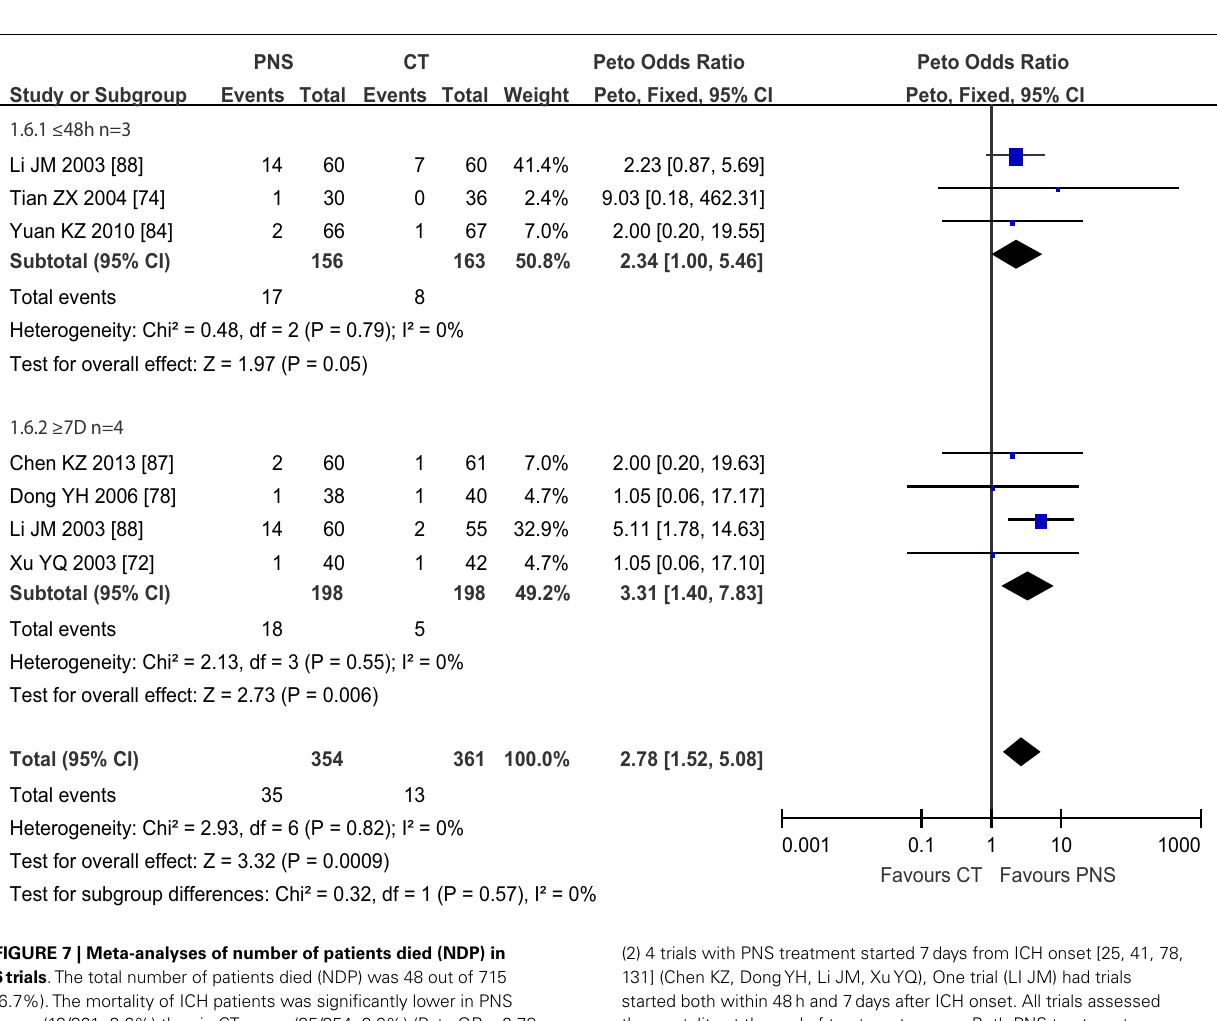
FIGURE 7 | Meta-analyses of number of patients died (NDP) in 6trials .The total number of patients died (NDP) was 48 out of 715 (6.7%).The mortality of ICH patients was significantly lower in PNS group (13/361, 3.6%) than in CT group (35/354, 9.9%) (Peto OR = 2.78; 95% CI = 1.52, 5.08; P = 0.0009).The trials were divided into two subgroups based on the intervention time of PNS: (1) 3 trials with PNS treatment started within 48h after ICH onset (Li JM,Tian ZX,Yuan KZ),